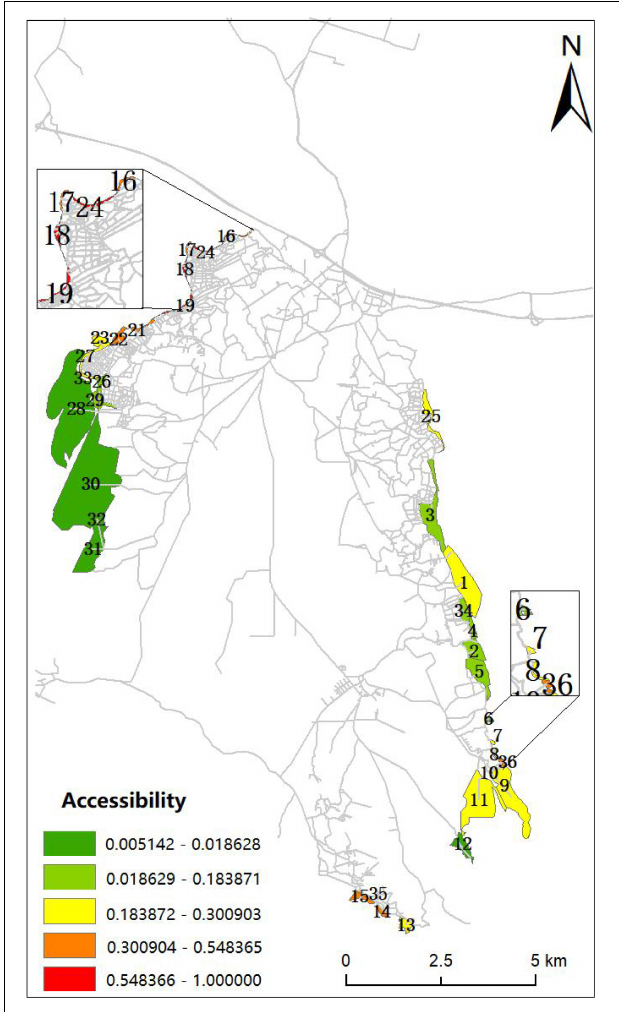
FIGURE 7 | Accessibility of willingness to protect mangroves and visits to